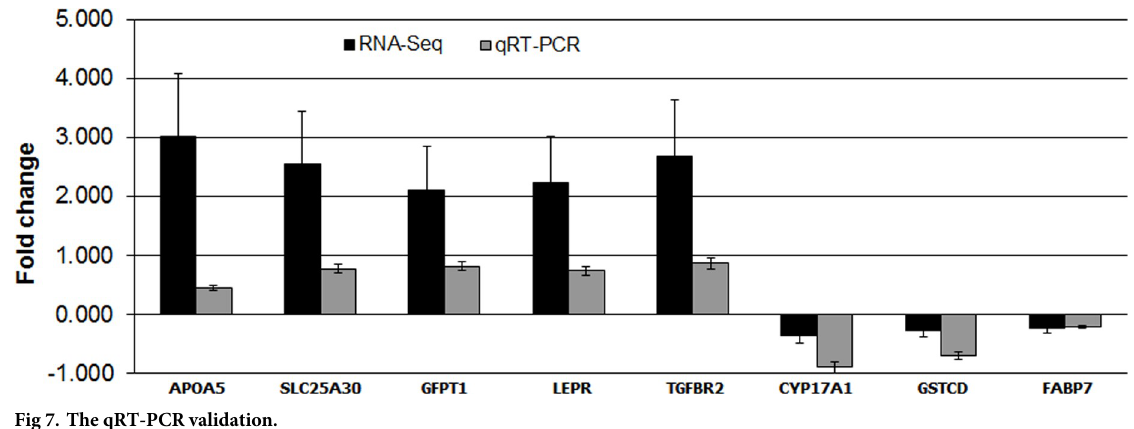
Fig 7. The qRT-PCR validation.